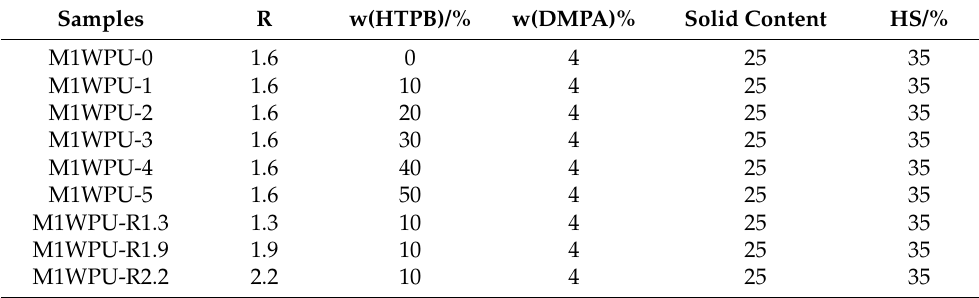
Table 1. The main compositions of the prepared waterborne